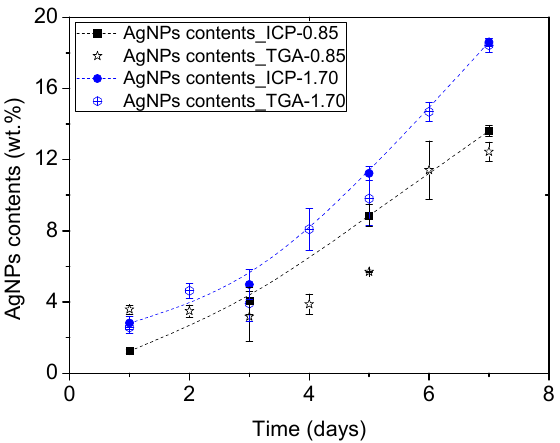
Figure 4. AgNPs content (wt.%) measured by thermo gravimetric analysis (TGA) and induced couple plasma-optical emission spectroscopy (ICP-OES) [10] in the functionalized ME/Ag foams obtained after different reaction times in two concentrations of AgNO 3 .